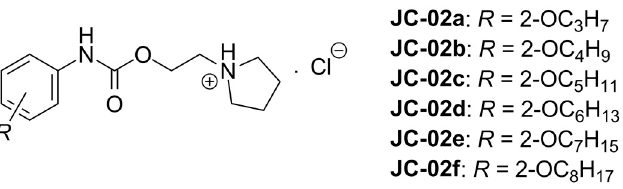
Figure 5. Chemical structure of the derivatives of 2-/3-alkoxyphenylcarbamic acids JC-02a – l (alkoxy = propoxy to octyloxy), which were in vitro screened against MT v H 37 R v , MK 235/80, MK 6509/96 and MA 330/80 [76], respectively.